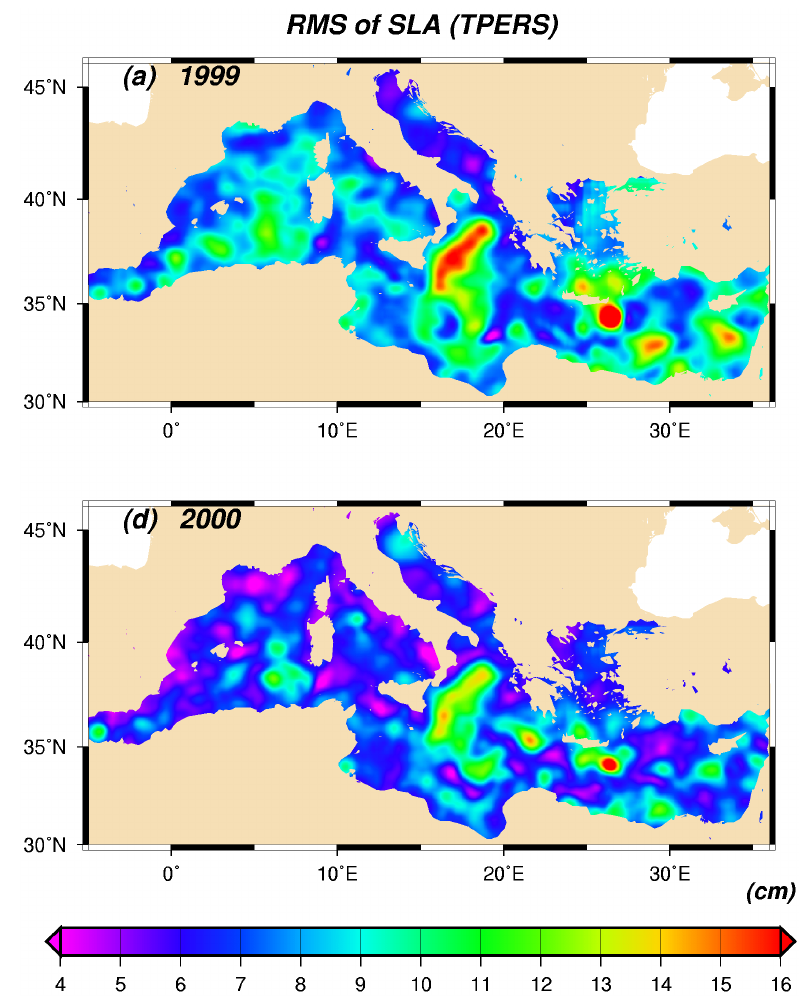
Fig. 2. RMS of SLA observed by T/P and ERS. Units are in cm. (a) for 1999 year, (b) for 2000 year.